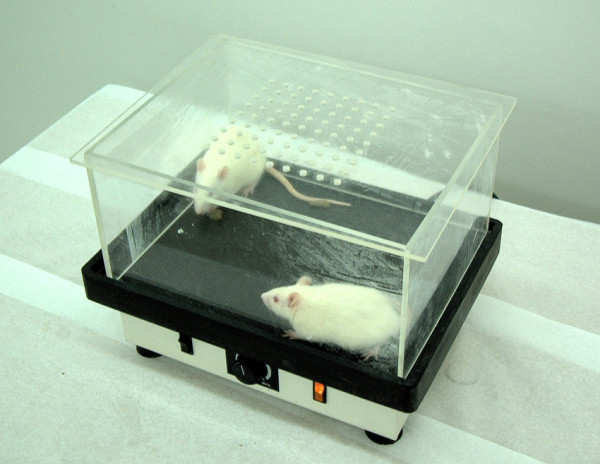
Plexiglass bordered vibrating plate used to administer mechanical low-magnitude high-frequency to osteoporotic rats.